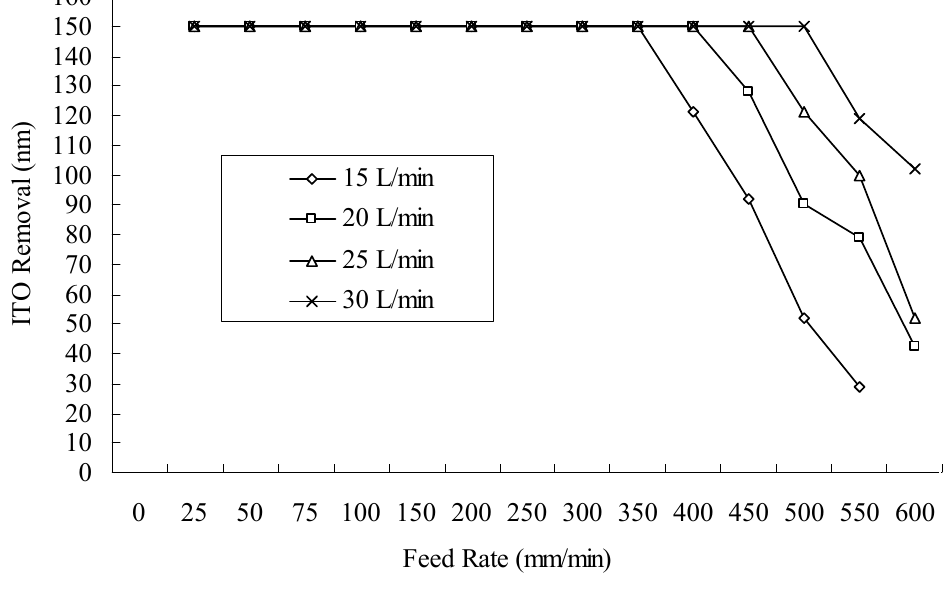
Figure 6. Amount removed at different feed rates of the workpiece using different flow of 10 wt% and PO4-3-P 5 wt%, 55 °C, 150 A, continuous rates of the electrolytes (NaNO 3 DC, negative-electrode 300 rpm).